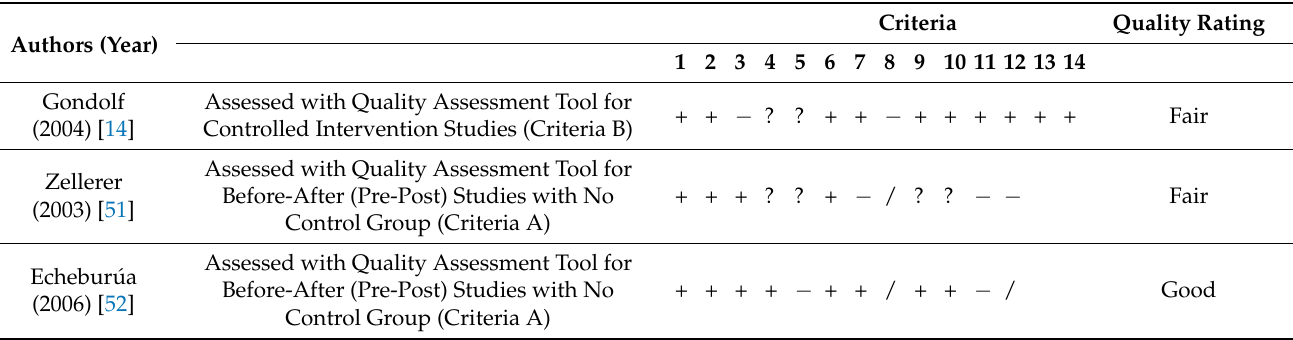
Table 2. Quality assessment of included quantitative